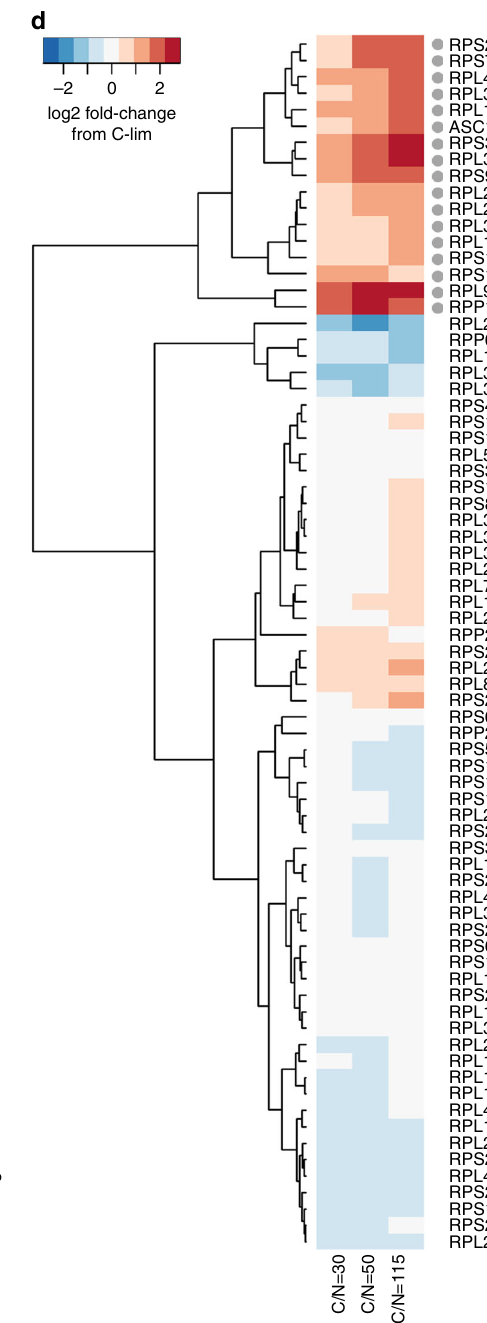
Fig. 5 Ribosome reserves contain diverse sub-stoichiometric ribosomal proteins (RP). a RP : rRNA ratio for each RP (abundance of each RP divided by rRNA abundance) was calculated in all growth conditions. The p -values indicated are from two-sided Student ’ s t -tests. Center line, median; box limits, upper and lower quartiles; whiskers, 1.5× interquartile range. b Model of ribosome complex diversity and abundance. Each complex ribosome contains 54 “ core ” RP subunits that are highly expressed and samples a subset of 22 RP subunits expressed an order of magnitude lower. c The total number of ribosomes in the cell decreases, whereas diversity of ribosomes varies quadratically, with the number of RP subunits complexed. d Relative abundance of RP subunits in N-limited chemostats compared with C-limited chemostat. RP paralogs were summed and labeled with standard gene name. The 17 RP subunits that were selectively upregulated by >2-fold in N-limited chemostats are indicated with a gray